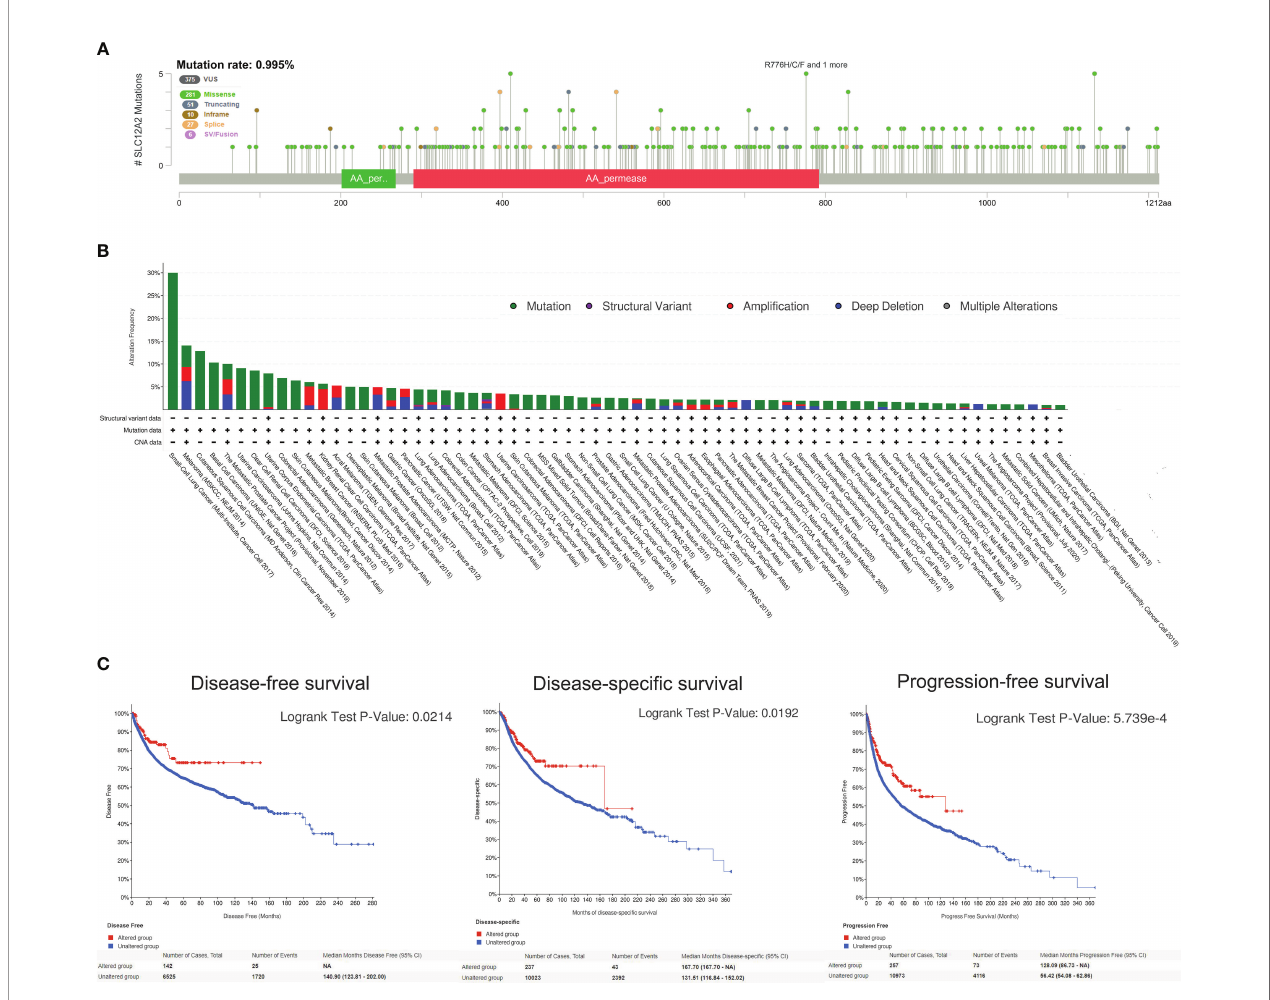
FIGURE 9 | NKCC1 mutations in pan-cancer samples in 48,834 pan-cancer from 166 independent studies. (A) The somatic mutation frequency of NKCC1 mutation and the main mutation site in pan-cancer samples (somatic mutations rate of NKCC1: 0.995%). (B) Mutation frequency and DNA structure variations NKCC1 in pan- cancer. (C) NKCC1 MUT could prominently prolong DFS ( p = 0.021), DSS ( p = 0.019), and OS ( p = 5.74e-04) compared with NKCC1 WT cancer patients. NA, Not